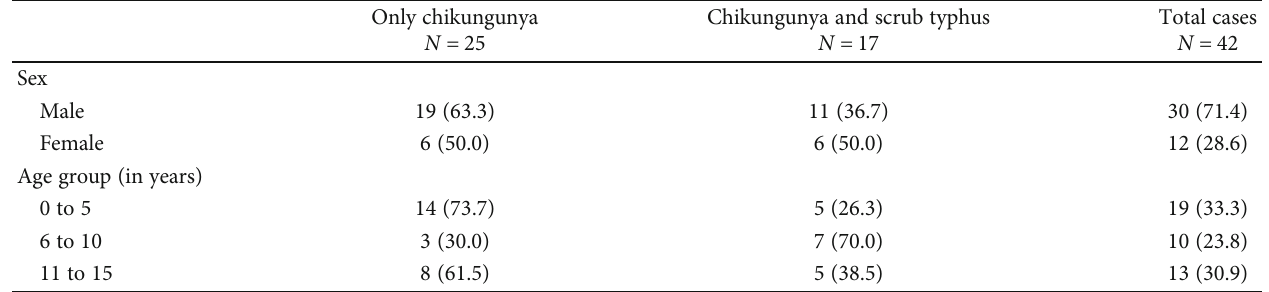
Table 1: Demographic data.